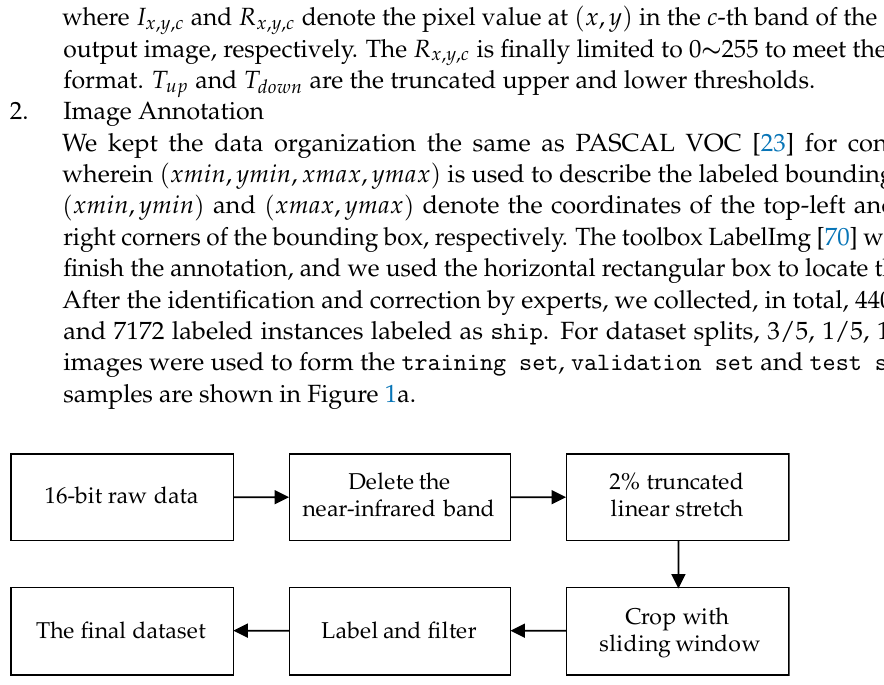
Figure 7. The flowchart of the dataset construction.